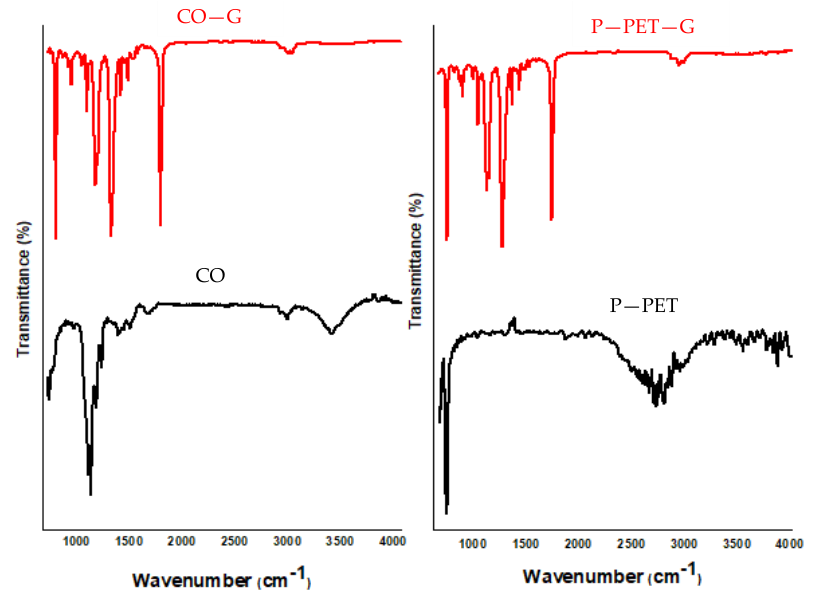
Figure 5. IR spectra of P — PET, CO, P — PET — G, and CO — GEO materials.